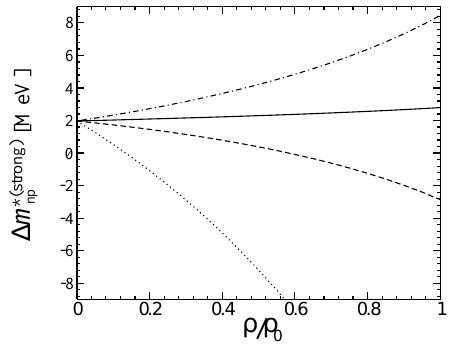
Fig. 6. Density dependence of the strong part ∆ m ∗ (strong) np of the neutron-proton mass di ff erence in nuclear matter. The abscissa represents the density ρ normalized to the saturation density of ordinary nuclear matter ρ 0 = 0 . 5 m 3 , while the ordinate shows the π mass di ff erence in units of MeV. The result in isospin-symmetric matter is plotted as a solid curve, the result of neutron-rich matter with δρ/ρ = 0 . 2 as dashed curve, the dotted curve represents pure neutron matter ( δρ/ρ = 1) and the dot-dashed curve proton-rich matter with δρ/ρ = 0 . 2. Figure from Ref. [43]. −